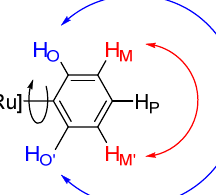
Figure 2. Rotation of phenyl group in the TpRu(L)(NCMe)Ph complexes; when the rotation of the Ru-C is rapid, time average of the H O and H O’ , H M , and H M’ is observed.